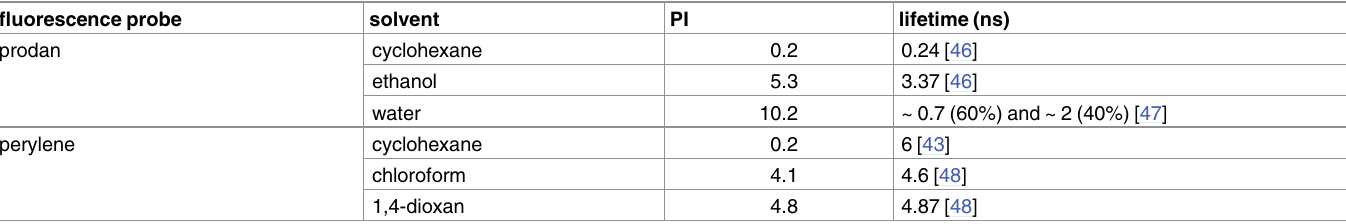
Table 2. Lifetimes of used fluorescence probes in different solvents and their polarity index (PI). fluorescence